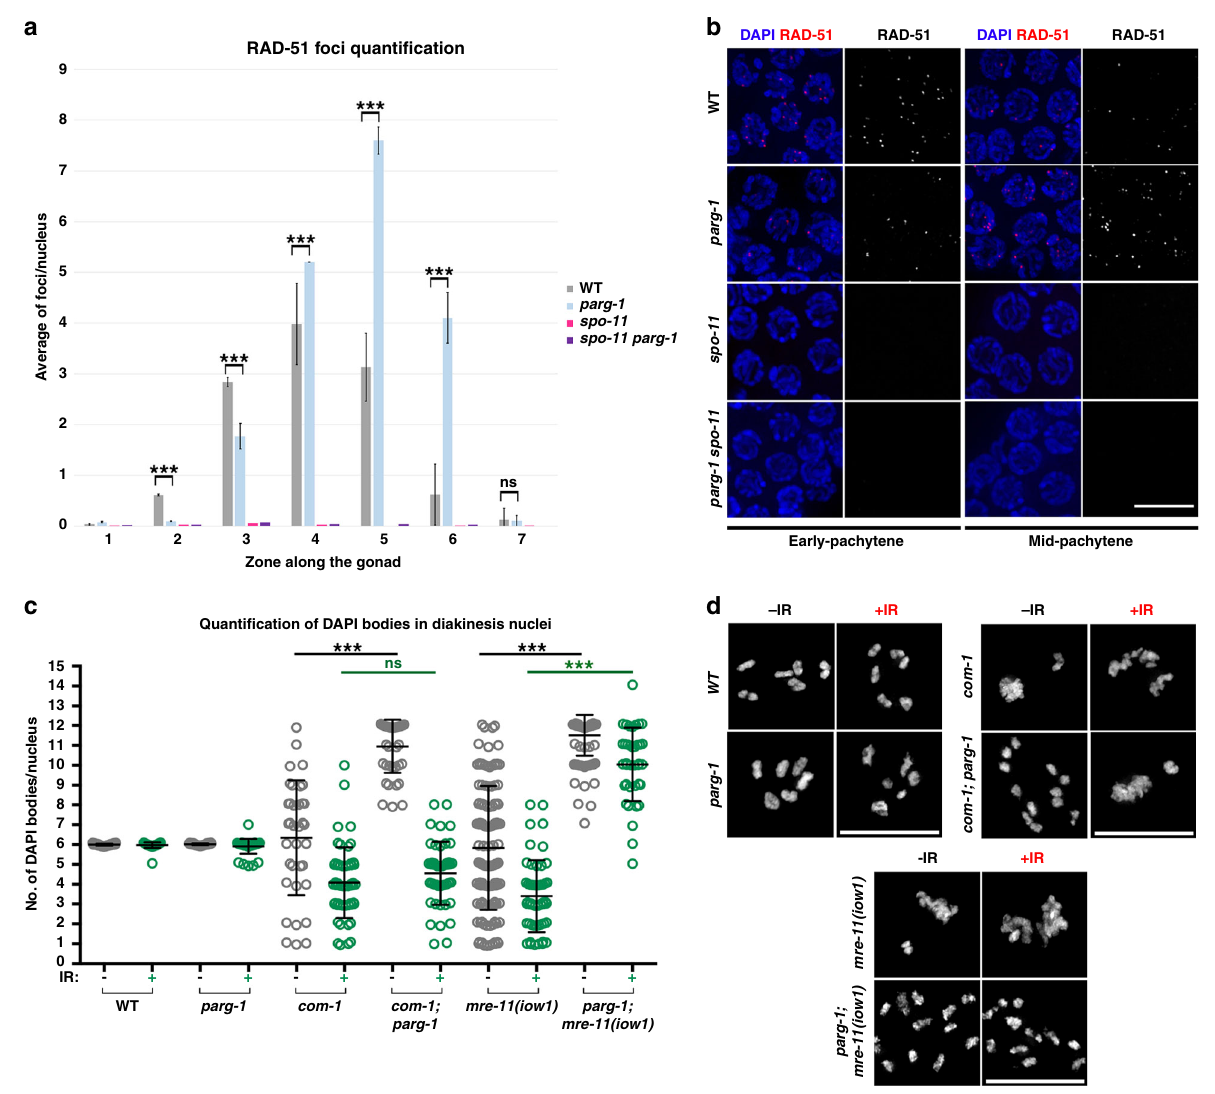
Fig. 3 Elimination of parg-1 function suppresses chromosome abnormalities in resection-defective mutants. a parg-1 mutants display SPO-11-dependent accumulation of RAD-51 foci. Error bars represent S.E.M. Asterisks indicate statistical signi fi cance assessed by unpaired t test (*** = p < 0.0001 and “ ns ” indicates not signi fi cant). Analysis was performed in at least three gonads for each genotype. Number of nuclei analysed for each genotype (from zone 1 to 7 respectively): WT (200, 205, 127, 181, 162, 170, 90); parg-1(gk120) (191, 256, 248, 177, 158, 126, 135); spo-11 (242, 236, 221, 204, 159, 158, 96); spo-11 parg-1(gk120) (205, 218, 203, 188, 135, 105, 81). b Representative examples of cells at different stages of the same genotypes analysed in ( a ). Scale bar 5 μ m. c Analysis of diakinesis nuclei in different genotypes before and 27 h after exposure to IR. Error bars represent standard deviation. Center of error bars indicates mean. Statistical analysis was performed with two-tailed nonparametric Mann – Whitney test. (*** p < 0.0001 and ns indicates not signi fi cant differences). Number of nuclei analysed at 0 and 10 Gy respectively: WT (35 – 94), parg-1(gk120) (33 – 88), com-1 (37 – 55), com-1; parg-1 (42 – 48), mre-11 (124 – 52), parg-1; mre-11 (110 – 40). d Representative images of diakinesis nuclei of the same genotypes scored in ( c ). Scale bar 5 μ Quanti fi cation of RAD-51 foci numbers in parg-1(ddr50) and were observed for both parg-1(gk120) and parg-1(ddr50) alleles in parg-1(ddr50); him-5 mutants was comparable to parg-1(gk120) combination with him-5 mutation, further ruling out possible and parg-1(gk120); him-5 , respectively, indicating that the involvement of secondary mutations. aberrant RAD-51 expression pro fi le speci fi cally arises from Loading of RMH-1, MSH-5, and COSA-1, as well as bivalent parg-1 loss of function rather than unrelated mutations formation, were largely, although not completely, rescued by IR (Supplementary Fig. 3E). The defects in RAD-51 fi lament exposure (Fig. 4b – d and Supplementary Fig. 4), further formation observed in the parg-1; him-17 and parg-1; him-5 corroborating that the lack of COs was due to impaired DSB double mutants were correlated with defective loading of pro-CO formation. Abrogation of PARG-1 function also exacerbated factors such as HA::RMH-1, GFP::MSH-5 and OLLAS::COSA-1 the CO defect observed in both young (day #1) and old (day #2) (Fig. 4b, c and Supplementary Fig. 4) as we would expect for dsb-2 mutants (Supplementary Fig. 3G), which display an age- mutations that impair DSB formation. Analysis of diakinesis dependent loss in the pro fi ciency to induce DSBs 21 . These results indicate that loss of parg-1 function impairs a parallel, nuclei revealed an extensive lack of chiasmata (Fig. 4d) and him-17-, him-5 , and dsb-2 -independent pathway for DSB enhanced embryonic lethality (Supplementary Fig. 3F) in the induction. double mutants due to defects in CO repair. These phenotypes